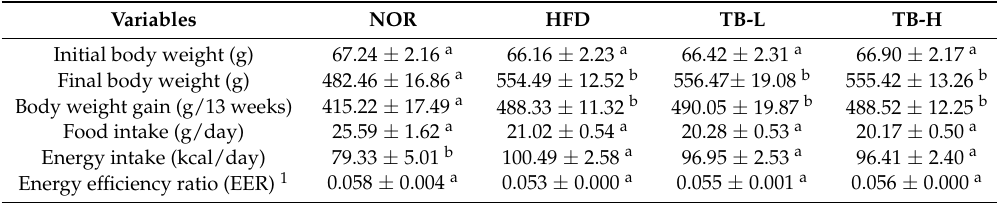
Table 3. Effect of tartary buckwheat extract on body weight and food